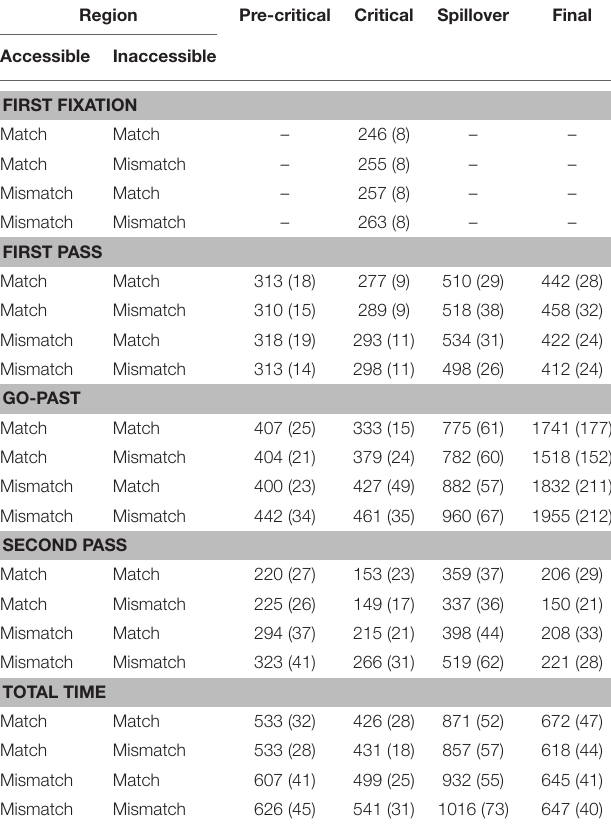
TABLE 7 | Means (and Standard Errors) for Experiment 4. Region Pre-critical Critical Spillover